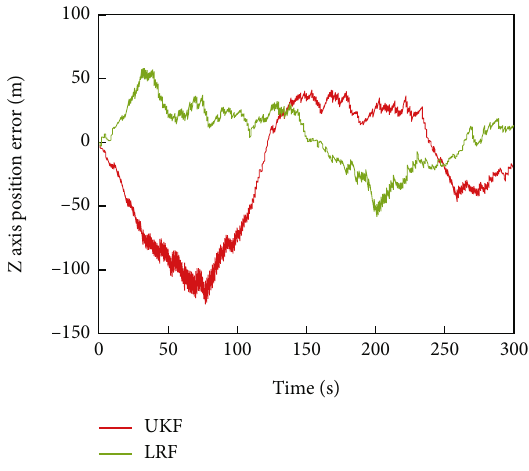
Figure 17: Yaw angle error contrast curves.